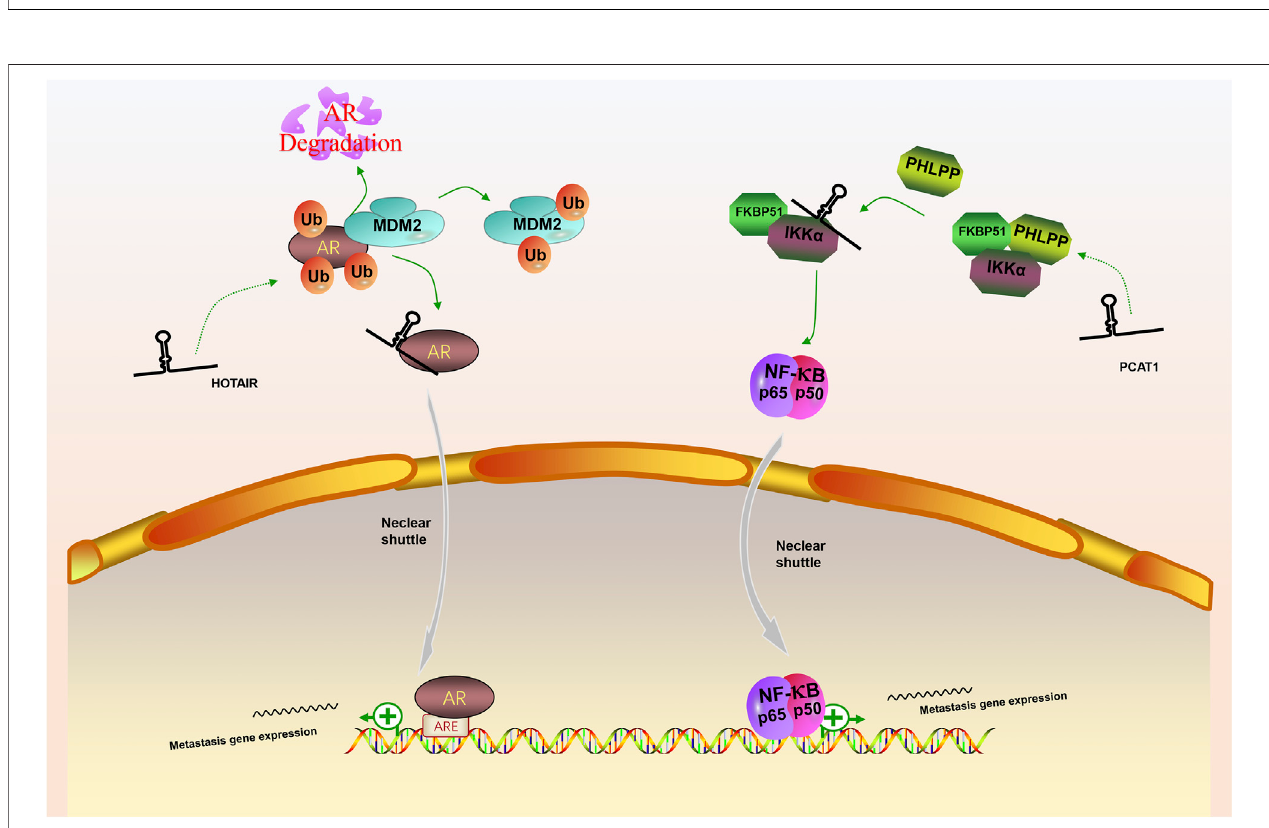
FIGURE 4 | The competing integration of the binding site between lncRNAs with speci fi c regulators to promote the stability of key signaling effectors. (1) LncRNA HOTAIR interfered the degradation of AR by MDM2 and promote the AR signaling pathway; (2) LncRNA PCAT1 activate NF- κ B signaling pathway via abolishing the inhibitory effect of PHLPP on IKK α